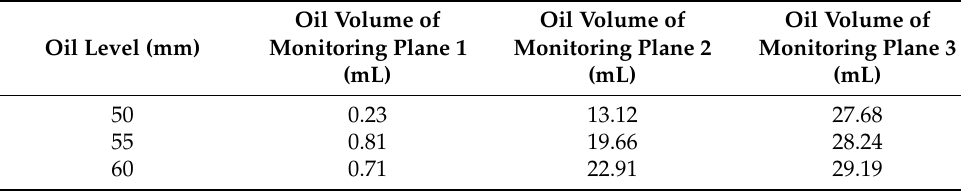
Table 4. Total oil volume versus oil